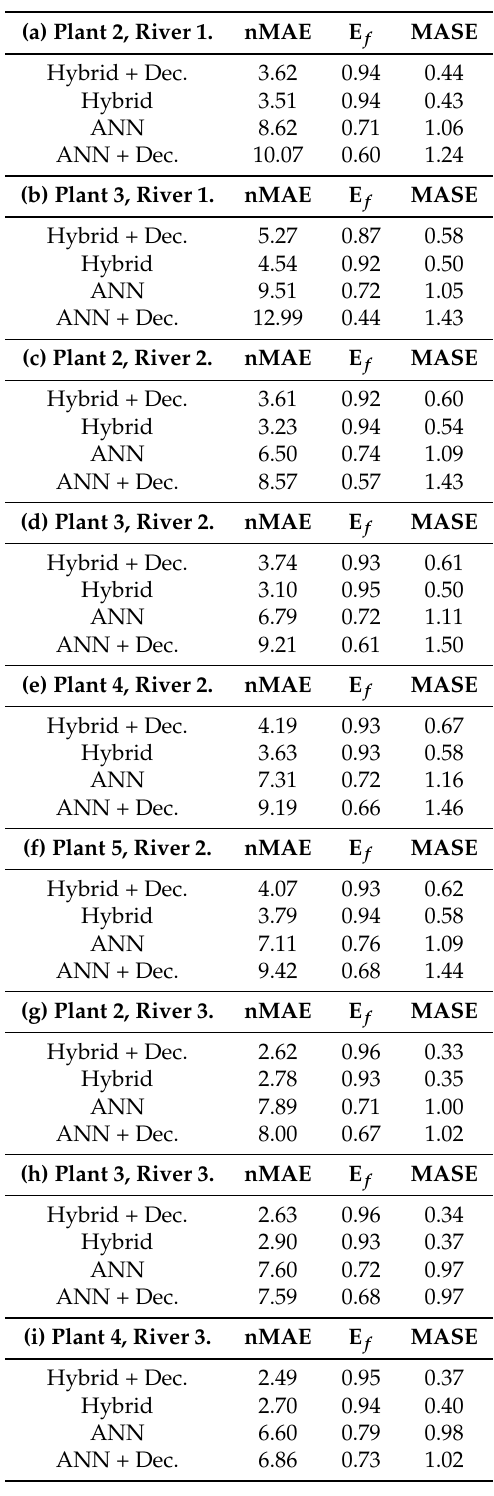
Table A1. Performance comparison: hybrid ANN with decomposition, hybrid ANN, ANN, and ANNs with